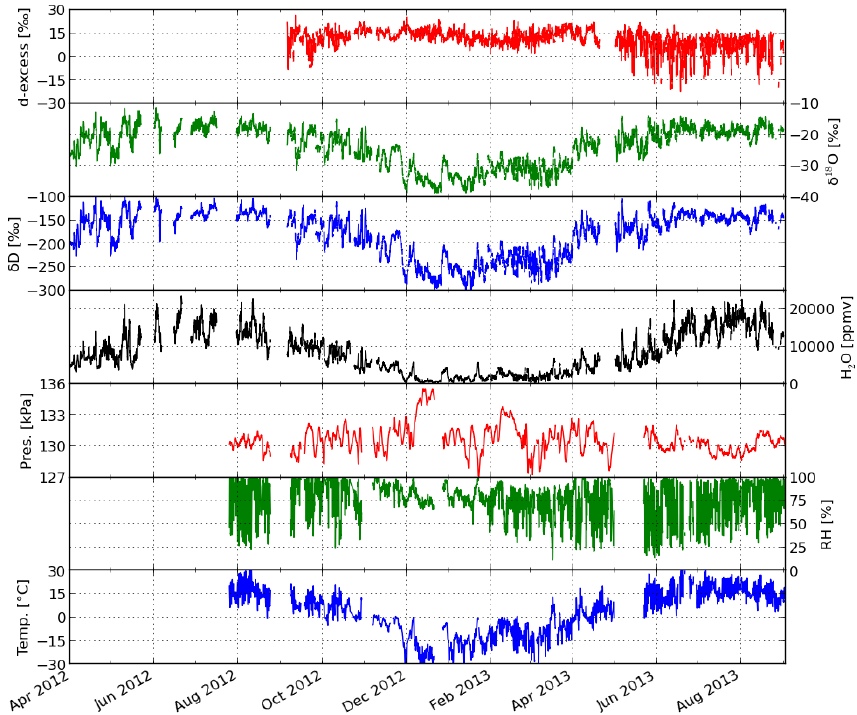
Figure 6. Isotopic and meteorological measurements at Kourovka site. Top to bottom: d-excess, δ 18 O and δ D in ‰, humidity concentration in ppmv, pressure in kPa, relative humidity in %, and temperature in ◦ C. Deuterium excess values are not reported before September 2012, due to instabilities of calibrations during this period. Table 2. δ D vs. δ 18 O (linear fit parameters for hourly averaged 33